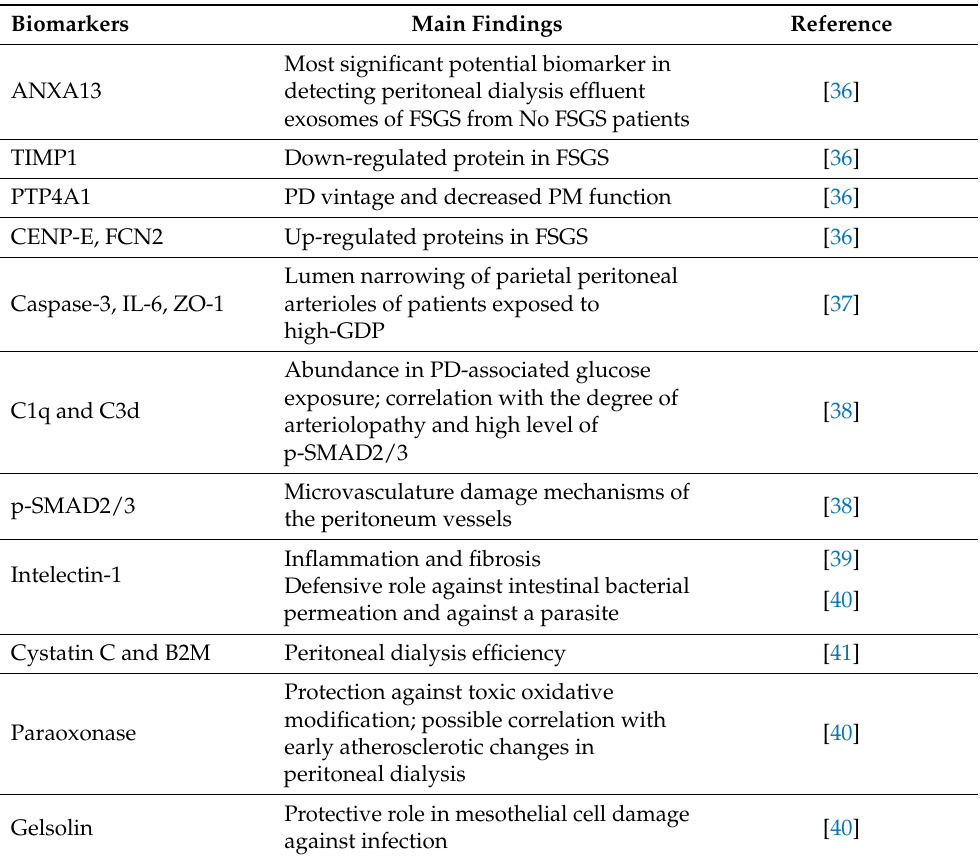
Table 1. Potential peritoneal-derived biomarkers in pediatric PD